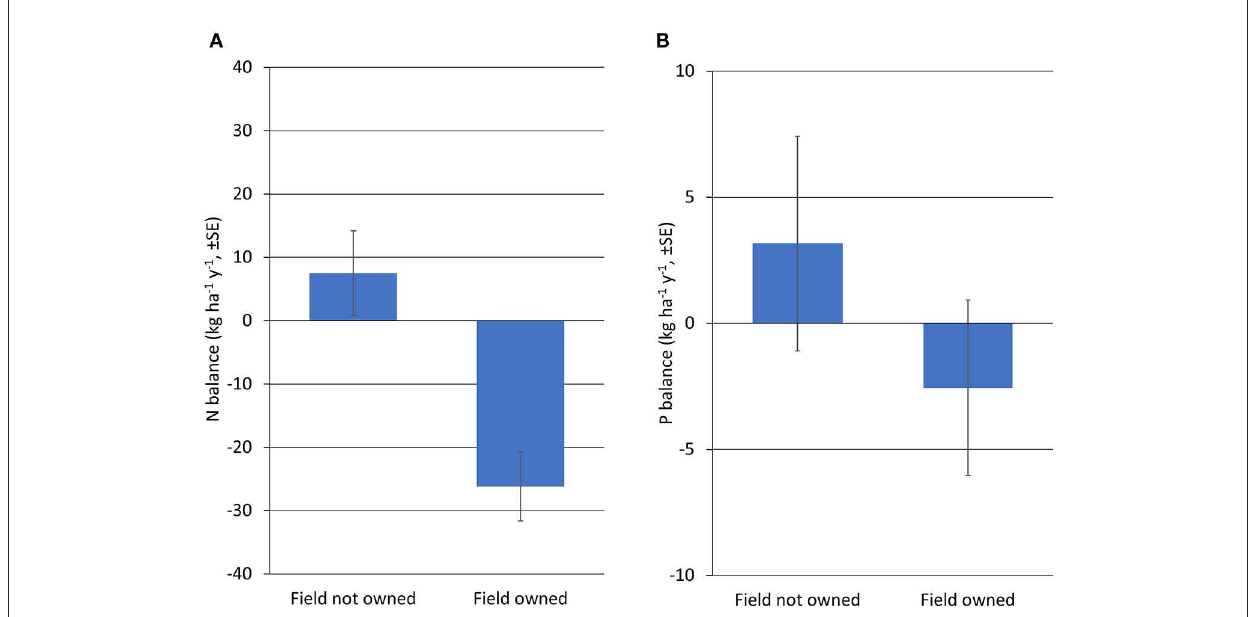
FIGURE4 Partial nutrient balances, incorporating nutrient inputs in manure and fertilizer, estimated nitrogen fixation, and crop exports in grain and residues, based on surveys regarding 45 farmers’ fields in Narumu Ward, Kilimanjaro Region, Tanzania: (A) nitrogen balances and (B) phosphorus balances, comparing fields that are owned by farmers with those not owned by farmers. Error bars show the standard error of each mean.